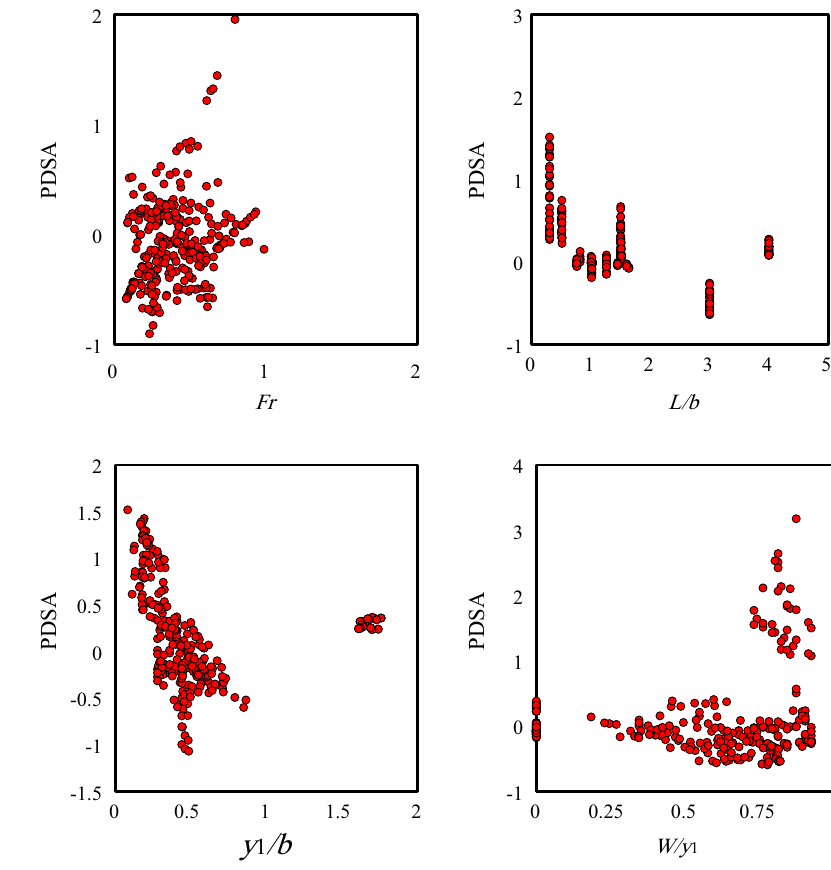
Fig. 12 PSDA results for supe- rior model (ORELM